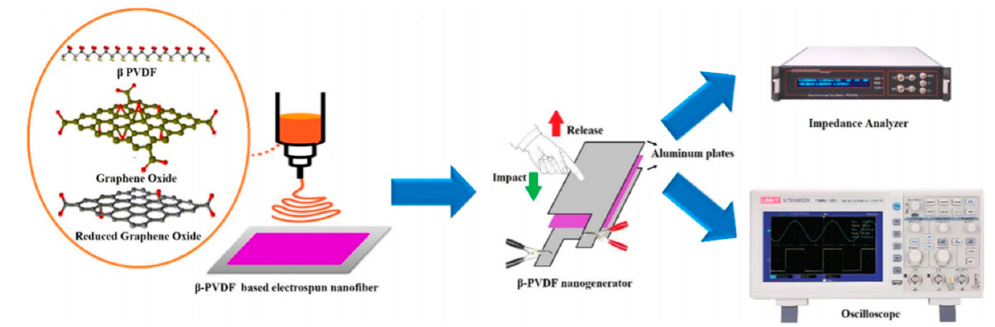
Figure 12. Schematic scheme of fabrication and application of the experimental procedure for β -PVDF-based nanogenerator. Reprinted with permission from [111].